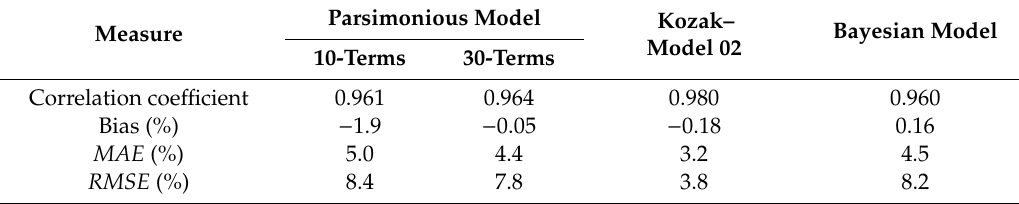
Figure 10. Taper modeling for the loblolly pine plantations from east Louisiana. An efficient Taylor series expansion contains five to 30 terms. Table 3. Comparison of the taper models for loblolly pine from east Louisiana.